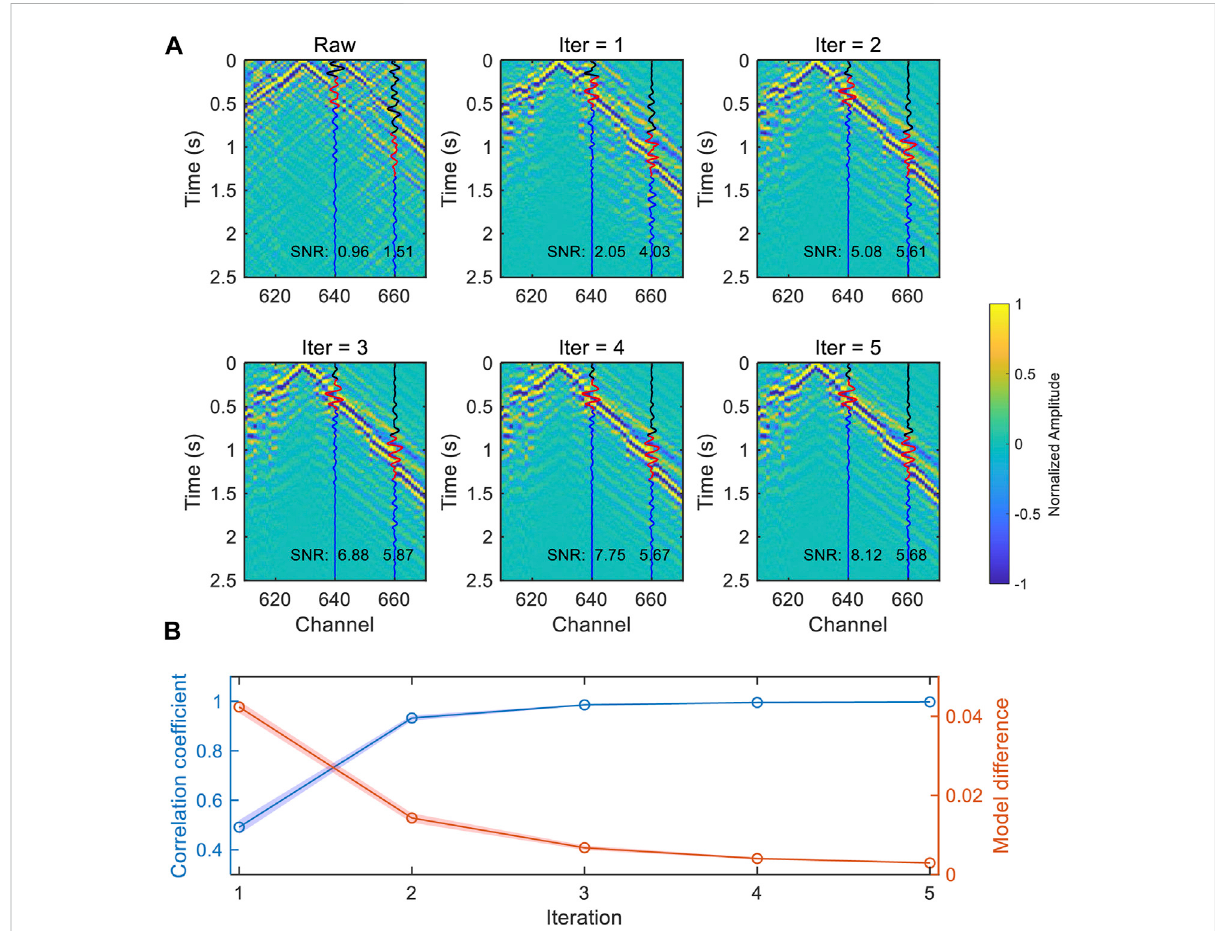
FIGURE 5 (A) Thevariationofthewaveformofsegment3withtheiterationusingtheTSImethod.ThevirtualsourceislocatedatCH630.Thebluelinesare thewaveformsofCH640andCH660,theblackandredlinesrepresentnoiseandsignalwindows,respectively. (B) Thevariationofmodelcorrelation coef fi cient and model difference with iteration. The blue and red shading represent 95% con fi dence intervals for the correlation coef fi cient and model difference,